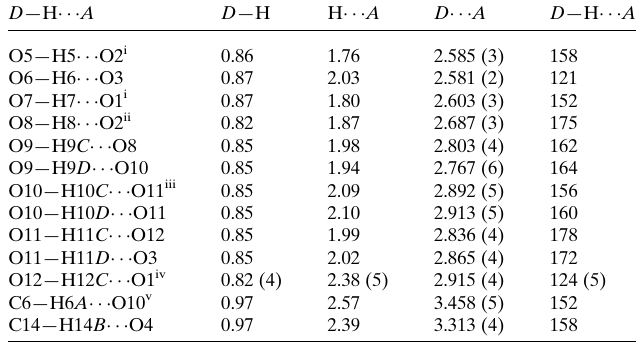
Table 2 Hydrogen-bond geometry (A˚ , (cid:4) ).